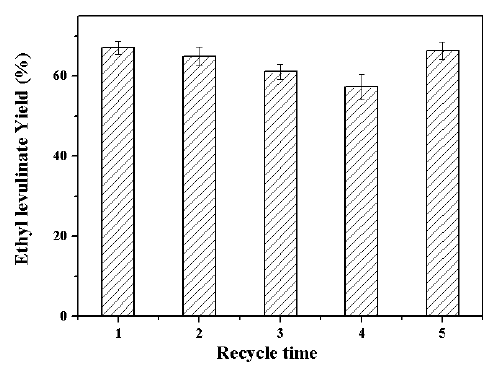
Figure 5. Reuse of the GCC catalyst. Reaction conditions: FA 1 g, ethanol 19 g, GCC 0.5 g temperature 423 K, reaction time 60 min.